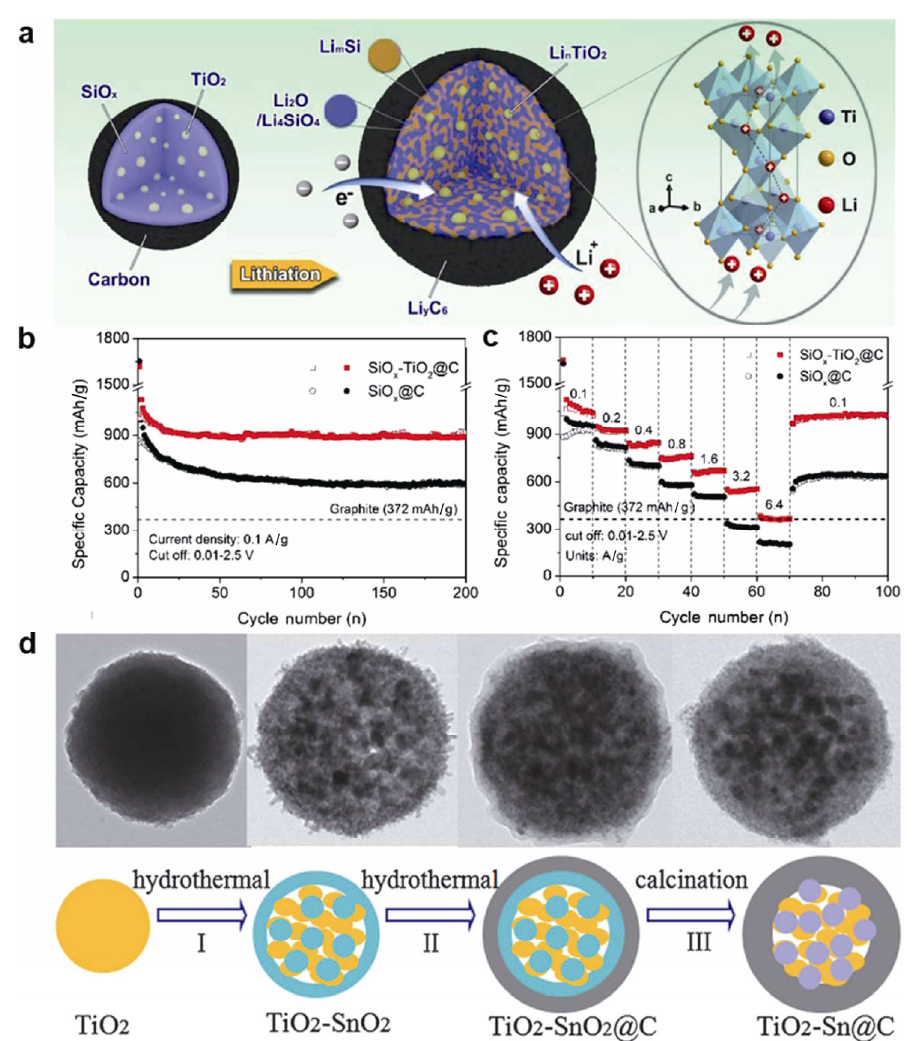
Fig. 7 Recent progress of TiO 2 hybrid nanocomposites with alloying-type anodes. (a) Schematic illustration for first lithiation process and (b, c) electrochemical performances of watermelon-like structured SiO x –TiO 2 @C nanoparticle. Reproduced with permission from Ref. [75], © John Wiley and Sons 2018. (d) Schematic illustration and TEM images of the fabrication process of TiO 2 –Sn@C core–shell microspheres. Reproduced with permission from Ref. [78], © The Royal Society of Chemistry